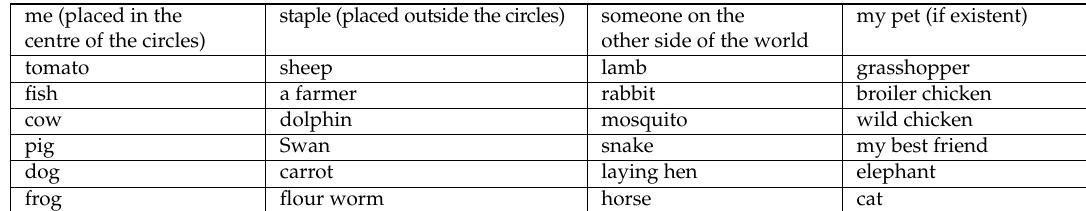
Table 1. Items used in the visualization exercise (in no particular